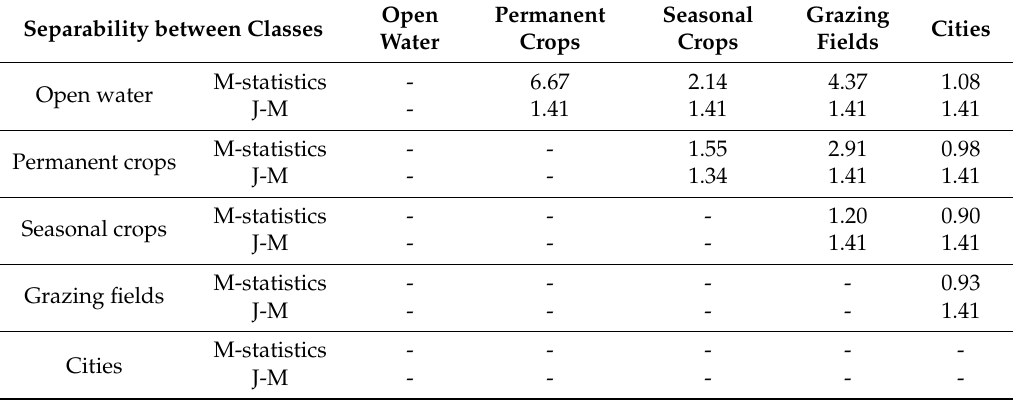
Table 1. Results of the separability between classes obtained from a k ‐ nearest neighbors supervised classification performed on ENVISAT ASAR GM images acquired during the dry season (July–September) between 2005 and 2008 using the M ‐ statistics and the Jeffries ‐ Matusita distance. Table